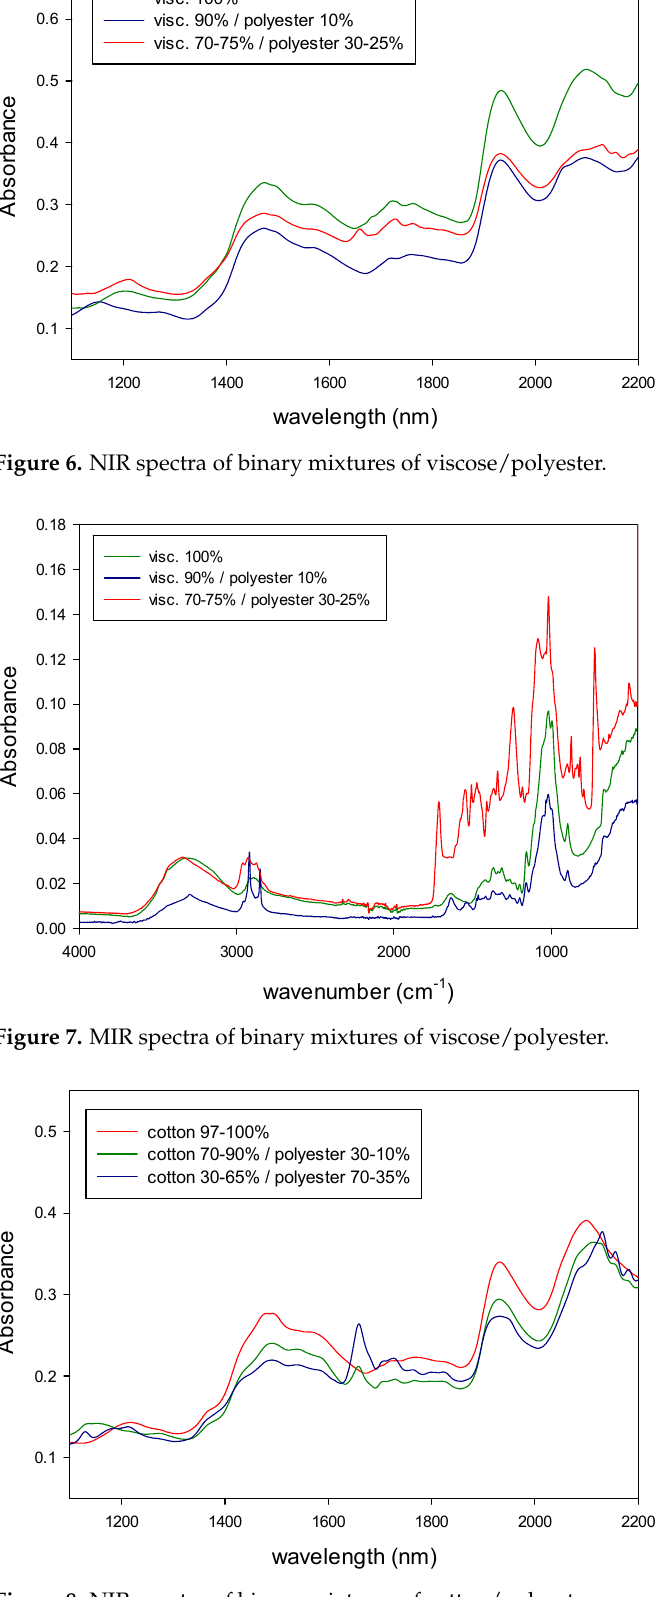
Figure 8. NIR spectra of binary mixtures of cotton/polyester.